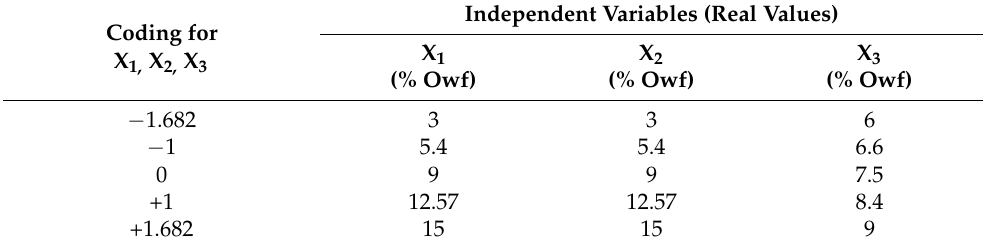
Table 1. Experiments